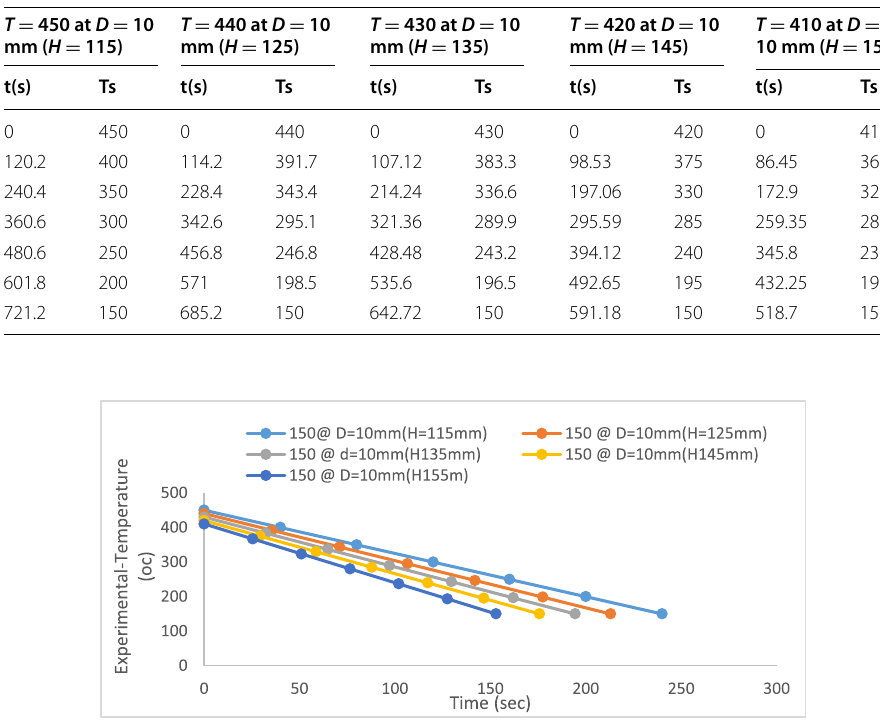
10 mm variant T and H for A-JIC = 10 =